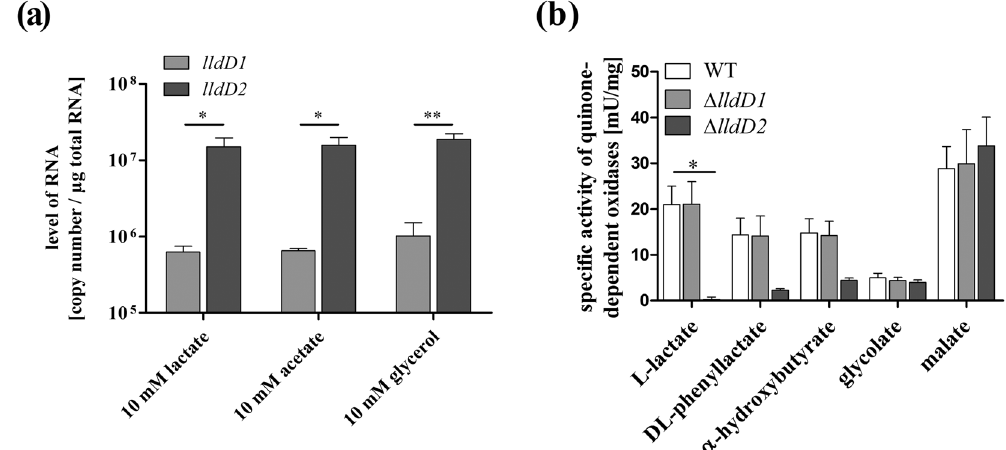
Figure 3. Mtb expresses lldD1 , but LldD1 does not oxidize various α -hydroxy acids. ( a ) To determine whether lldD1 is expressed in Mtb H37Rv growing at aerobic conditions on lactate, mRNA levels were measured by absolute quantification in RT-PCR. ( b ) To confirm the specific activity of LldD1 towards a selection of α -hydroxy acids, the Mtb H37Rv wild type, the Δ lldD1 mutant and the Δ lldD2 mutant were grown in rich culture medium, and enzyme activity assays were performed with cell extracts using lactate, DL-phenyllactate, α -hydroxybutyrate, glycolate, or malate as substrate. Enzymatic activity was detected in the wild type and the Δ lldD1 mutant. Enzymatic activity was abolished in the Δ lldD2 mutant on lactate, but also on DL-phenyllactate and α -hydroxybutyrate. Data represent the mean of three independent experiments; error bars indicate the